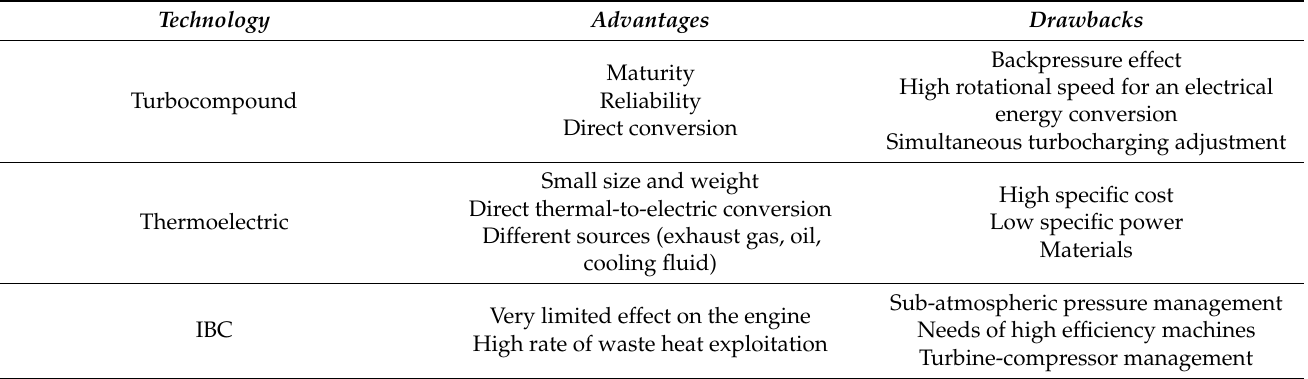
Table 4. Advantages and drawbacks of the technologies